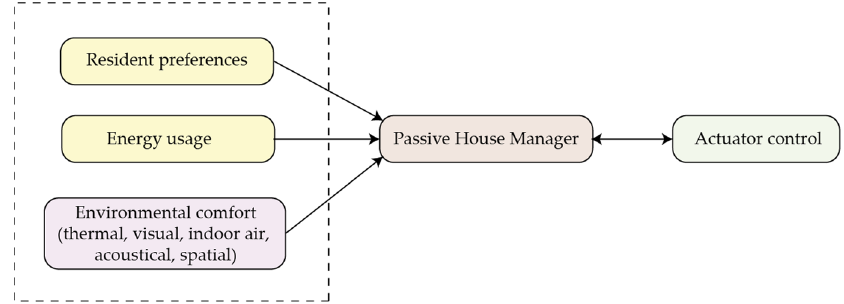
Figure 5. Schematic view of a passive house system manager (after Ref. [38]).